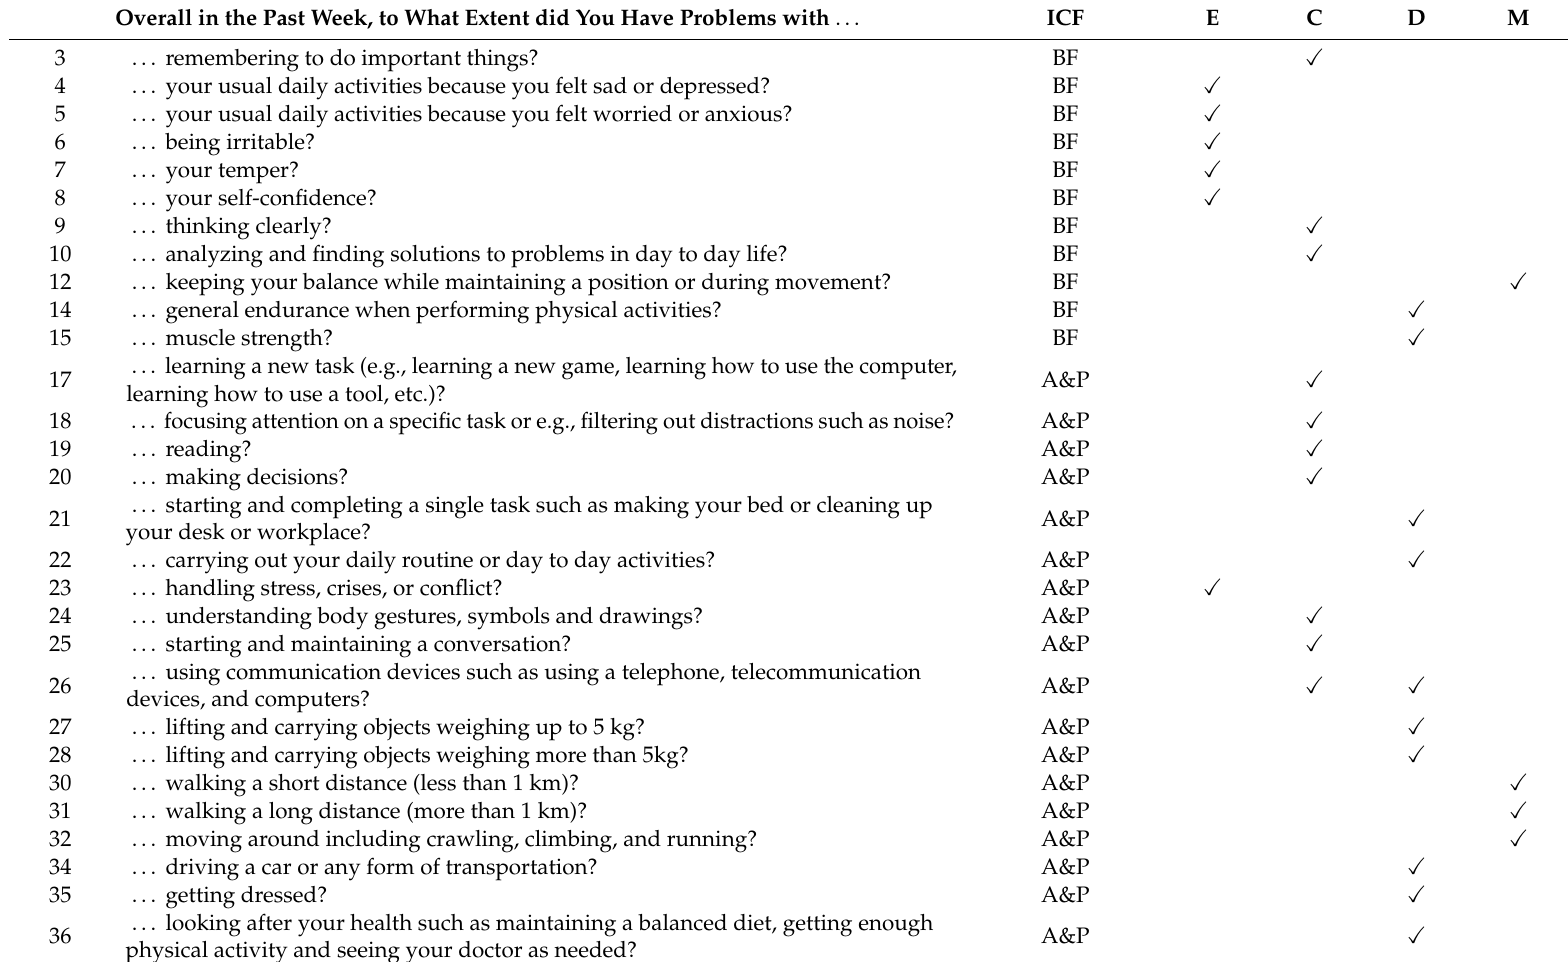
Table 1. Items of The Work Rehabilitation Questionnaire (WORQ) subscores. Overall in the Past Week, to What Extent did You Have Problems with